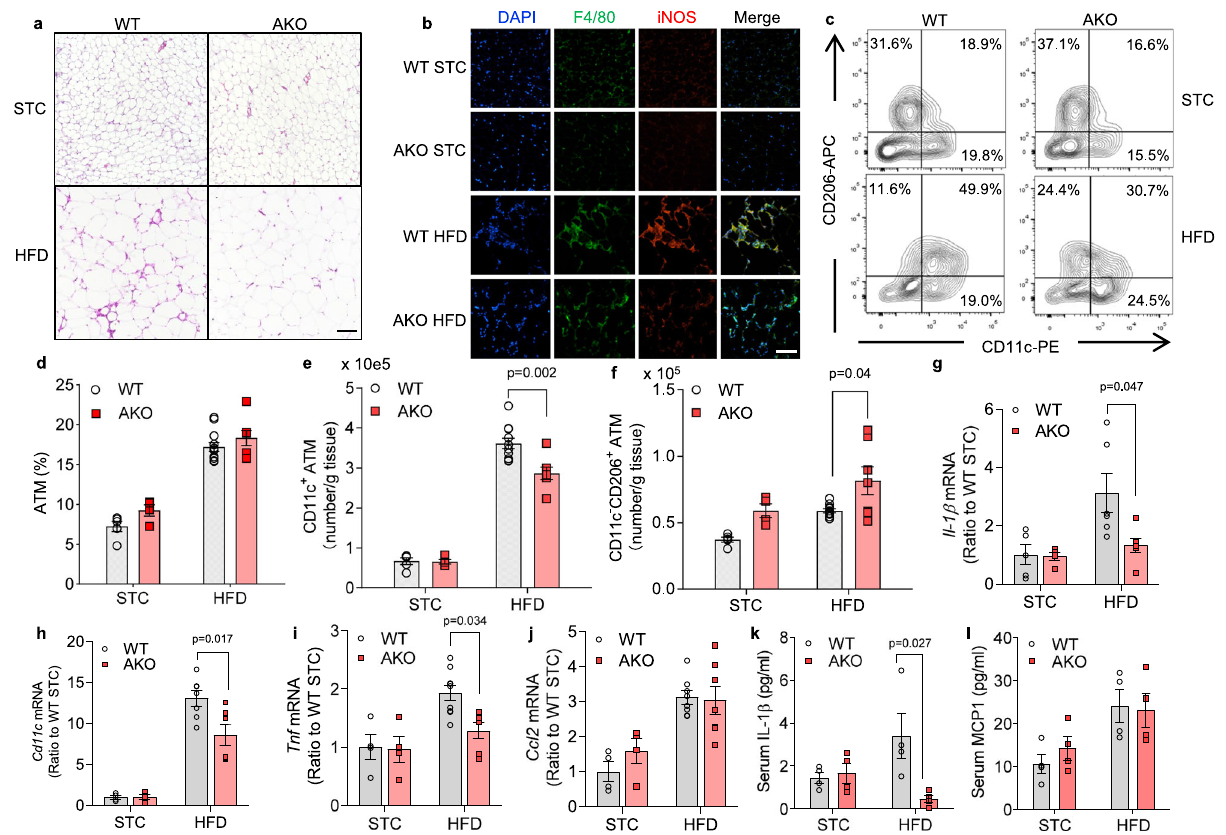
Fig. 3 | Obesity-induced adipose in fl ammation is attenuated by lactate deple- tion in adipocytes. Wildtype (WT) and adipocyte-speci fi c Ldha knockout (AKO) micewerefedwithstandardchow(STC)orhighfatdiet(HFD)for4monthsbefore epididymal white adipose tissue (eWAT) was isolated for analysis. a HE staining of eWAT; scale bar, 100 μ m. b Immuno fl uorescence staining of iNOS and F4/80 in eWAT;scalebar,100 μ m. c – f SVFineWATwassubjectedto fl owcytometryanalysis formacrophagesubtypes.STC-WT: n =5( c – f );STC-AKO: n =4( c – f );HFD-WT: n